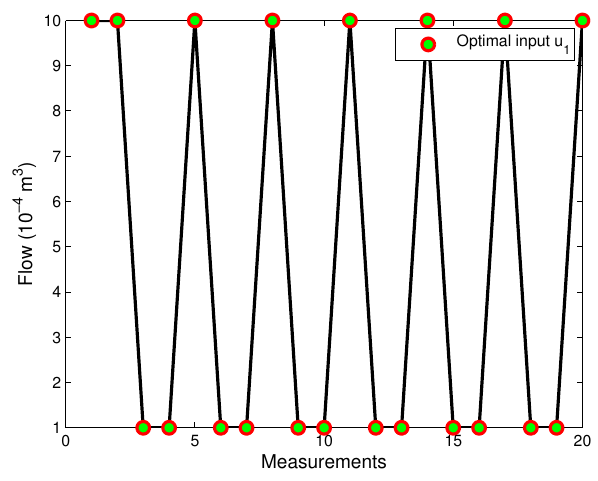
Figure 13. D-optimum pump control signal u 1